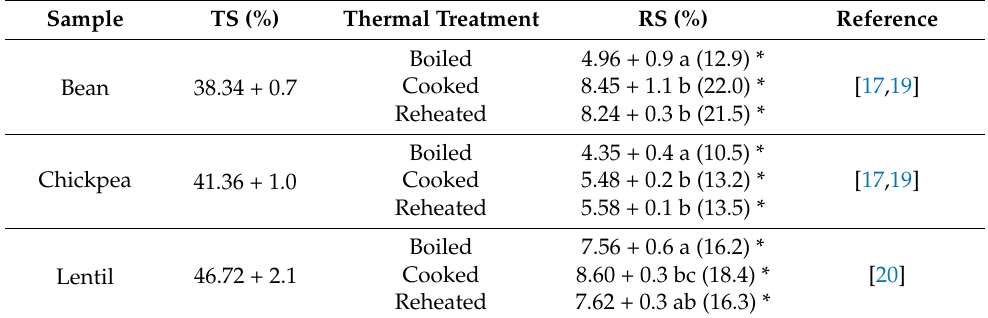
Table 3. Starch of whole legume seeds.